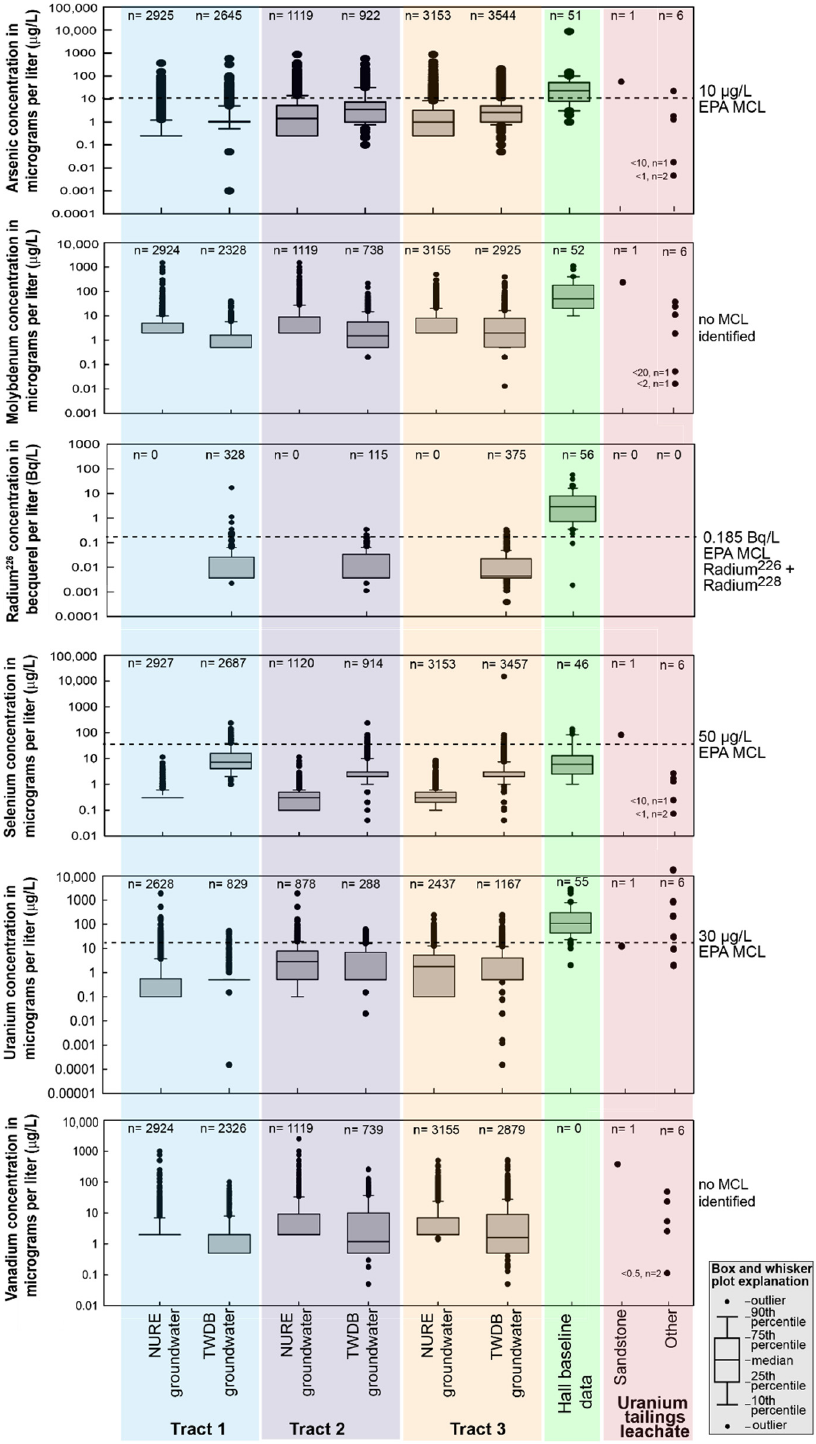
Figure 7. Arsenic, molybdenum, radium 226 , selenium, uranium, and vanadium concentrations in groundwater from the NURE [57,101] data (NURE groundwater) and Texas Water Development Board (TWDB) data [102]. Data are separated by permissive tracts 1, 2, and 3. The EPA maximum contaminant level (MCL) is shown where available for particular elements [103]. Baseline data are from Hall [104]. Leachate data [62] were produced for some of the tailings samples shown in Fig- ure 5, using EPA Method 1312 [105].